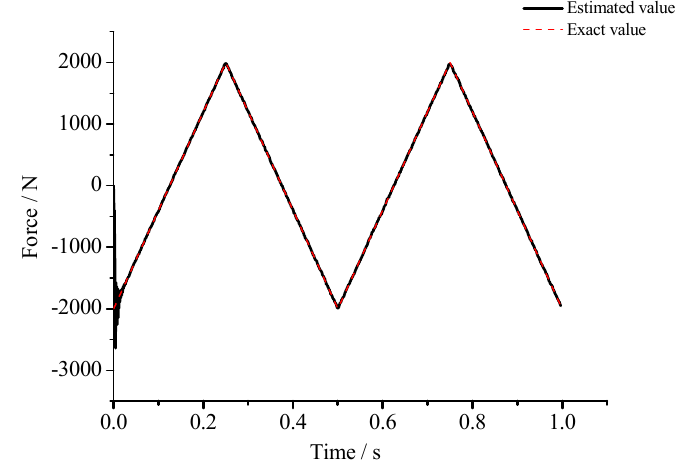
Figure 4. Estimation results of the sinusoidal input force ( Q w = 1 × 10 − 3 , σ = 1 × 10 − 6 ) . Materials 2017 , 10 , 1162